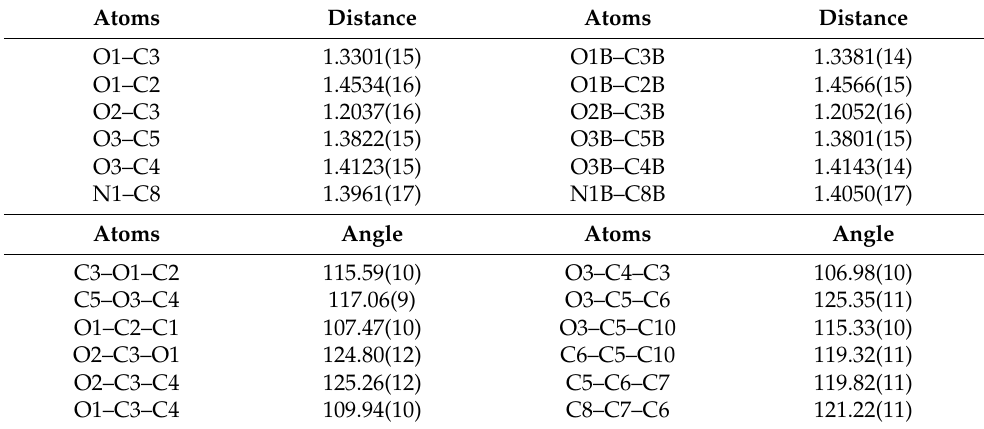
Table 1. Selected geometric parameters [Å, ◦ ] for 4